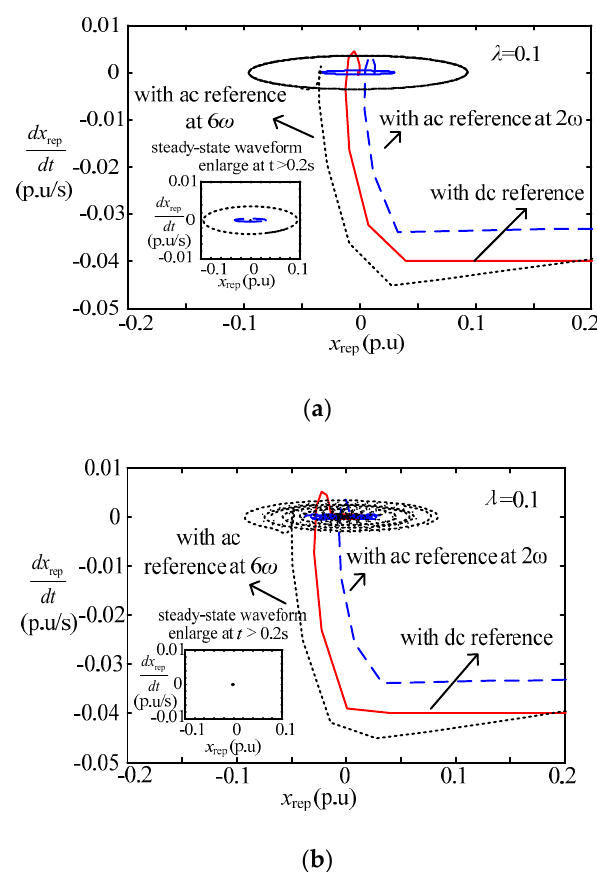
Figure 5. Phase plane trajectory with different tracking reference. ( a ) Phase plane trajectory with different tracking references of ISMC; ( b ) Phase plane trajectory with different tracking references of MRSMC.